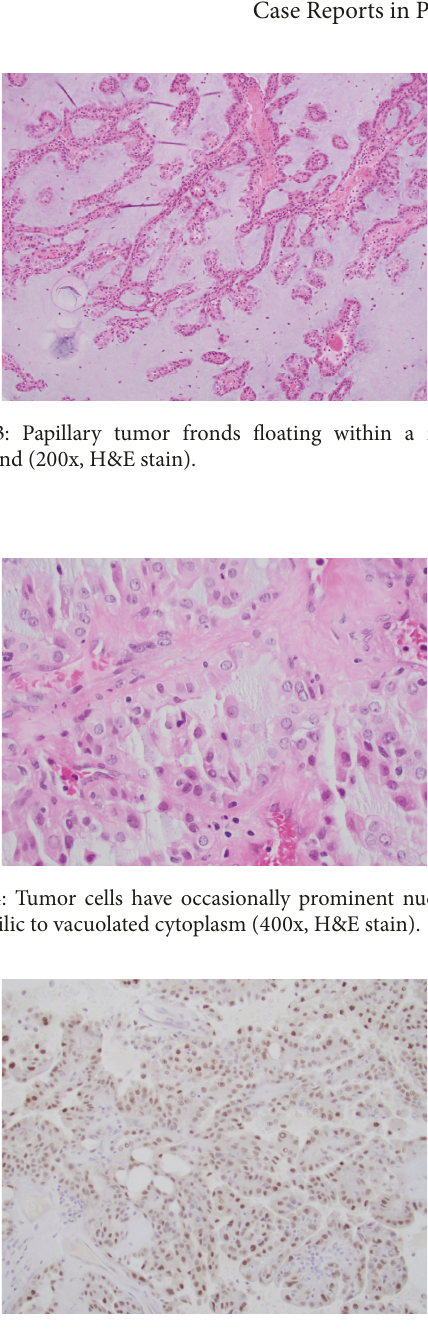
Figure 5: Diffuse nuclear positivity to Pax-8